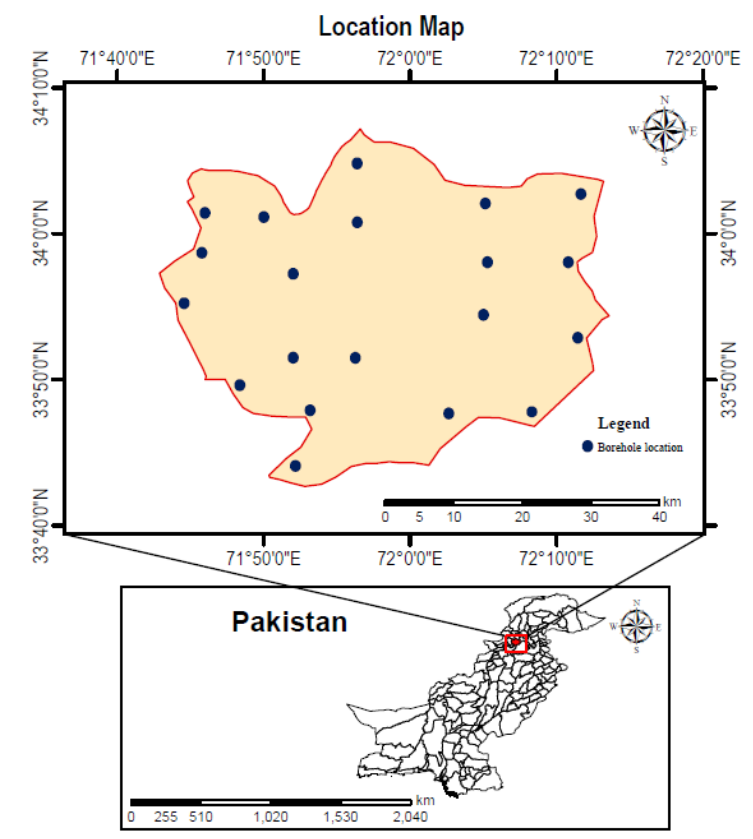
Figure 4. Location map of the study